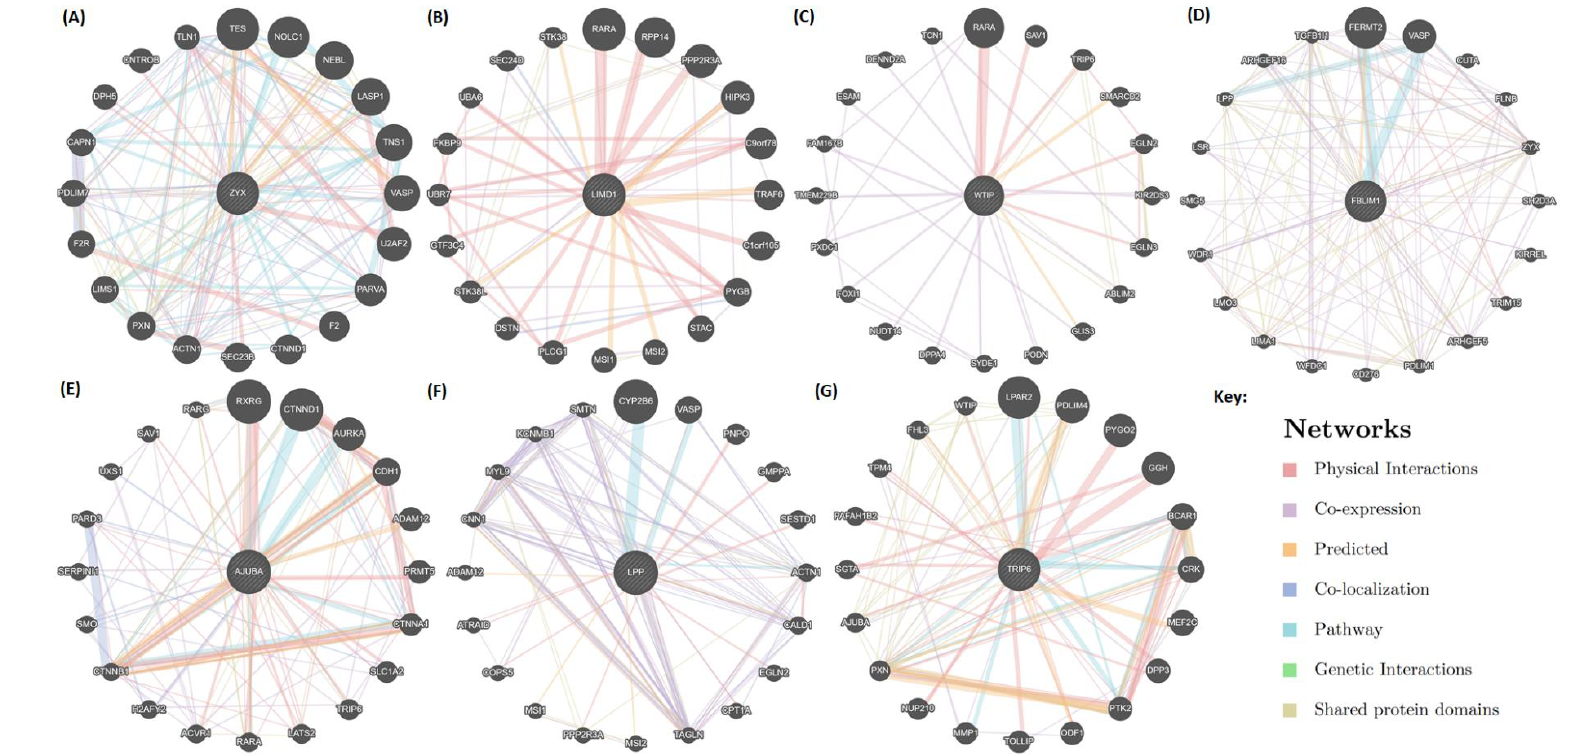
Figure 7. Pathway analysis by GeneMANIA. GeneMANIA highlighted the pathways that each protein member interacts within a cell. This helped us identify various proteins that interact with the query protein ( A ) Zyxin, ( B ) LimD1, ( C ) WTIP, ( D ) FBLIM, ( E ) AJUBA, ( F ) LPP and ( G ) TRIP6 . The connections are shown by blue lines, the width of each line represents the degree of interaction through weighted representation. The thicker line represents more interaction and vice versa